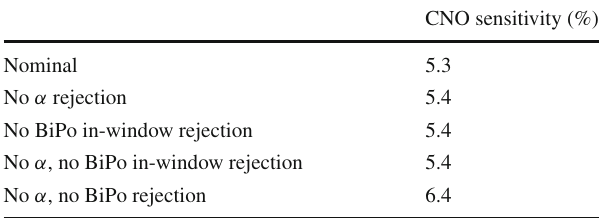
CNO sensitivity